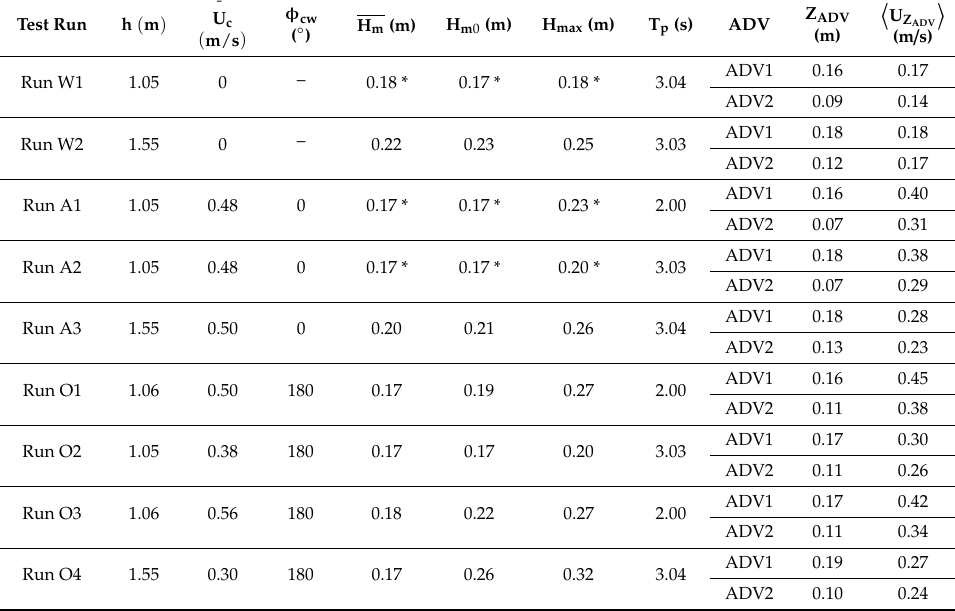
Table 1. Hydrodynamic forcing during the experimental runs. Symbols h: mean water dept U c h;: depth-averaged, mean current speed (from pump calibration); φ cw relative angle between the mean current and the direction of wave propagation; H m : mean wave height; H m0 : zero-moment significant wave height; H max : maximum wave height (* indicates values derived from measured velocities using linear wave theory); T p : peak wave period; Z ADV : height of ADV measurement (sampling (cid:68) (cid:69) volume) above bed at start of run; U Z : mean (ensemble-averaged) flow velocity at height of ADV ADV